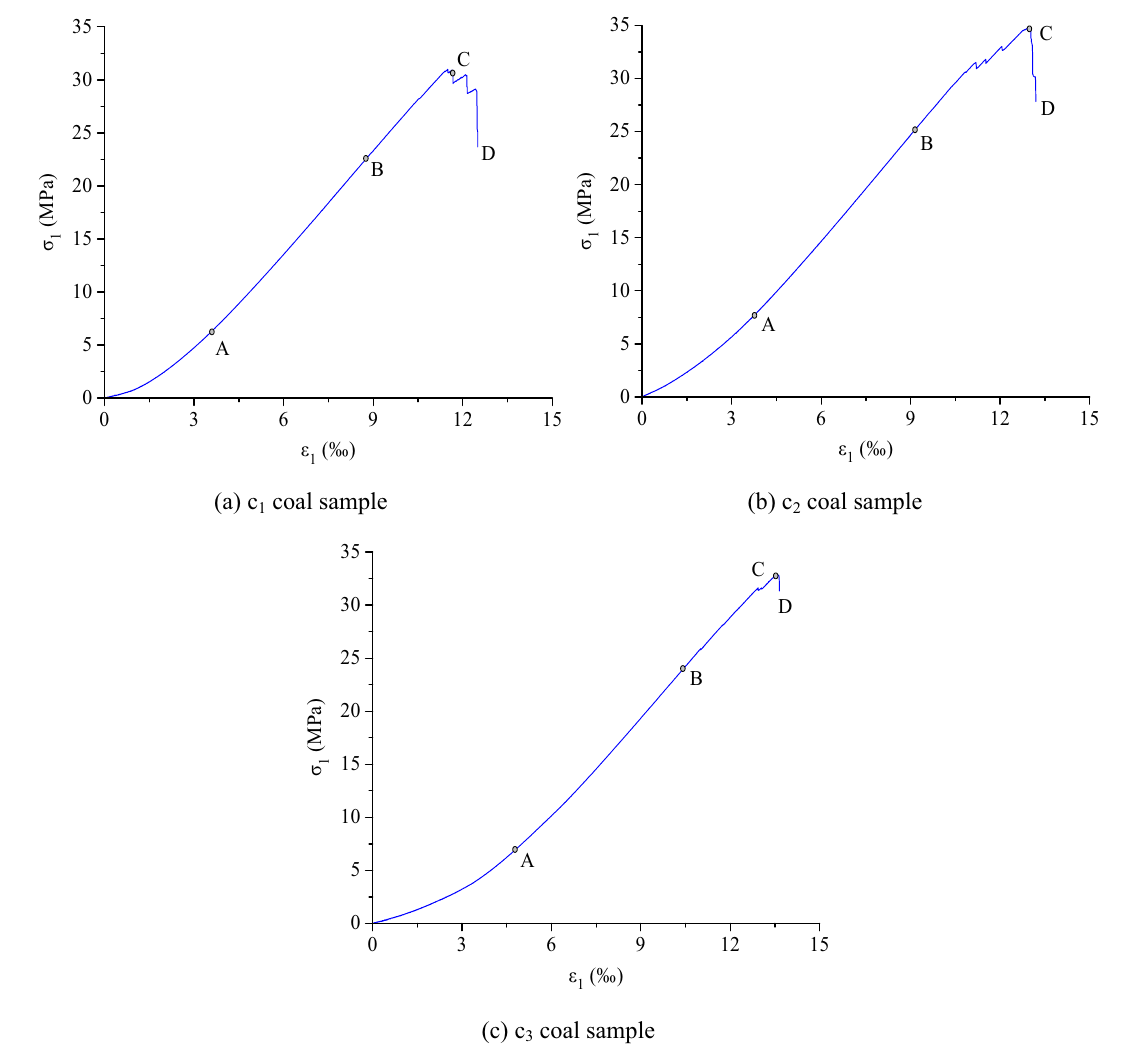
Fig. 3 Complete stress–strain relationship curve of raw